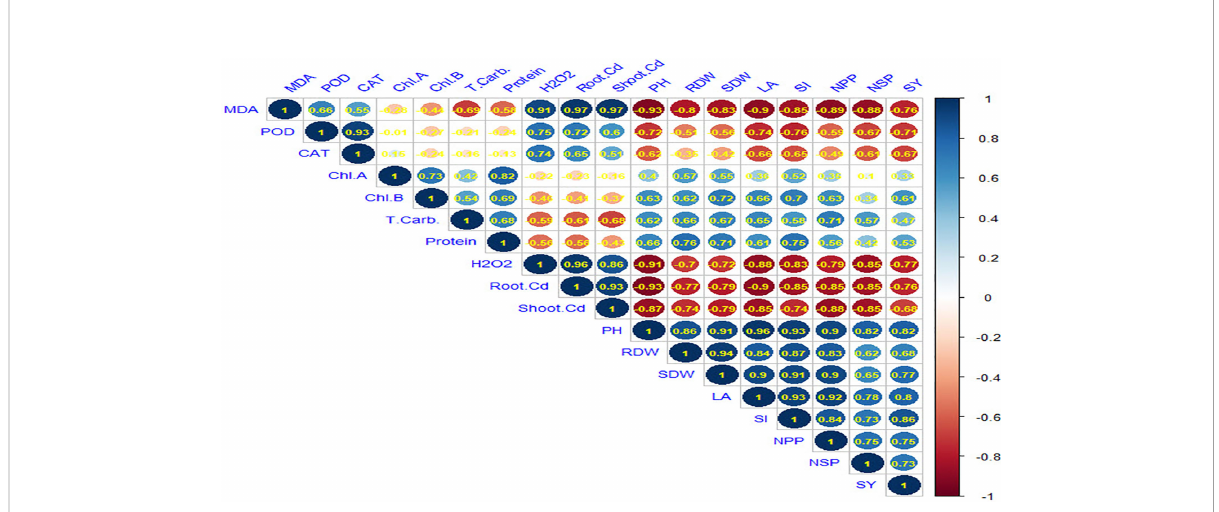
FIGURE 9 Spearman correlation matrix among malondialdehyde (MDA), antioxidant enzymes peroxidase (POD), antioxidant enzymes catalase (CAT), chlorophyll a (Chl.A), chlorophyll b (Chl.B), total carbohydrates (T.Carb.), Hydrogen peroxide ( H 2 O 2 ), root cadmium (Root Cd), shoot cadmium (Shoot Cd), plant height (PH), root dry weight (RDW), shoot dry weight (SDW), leaf area (LA), weight of 100 seeds (SI), number of pods/plant